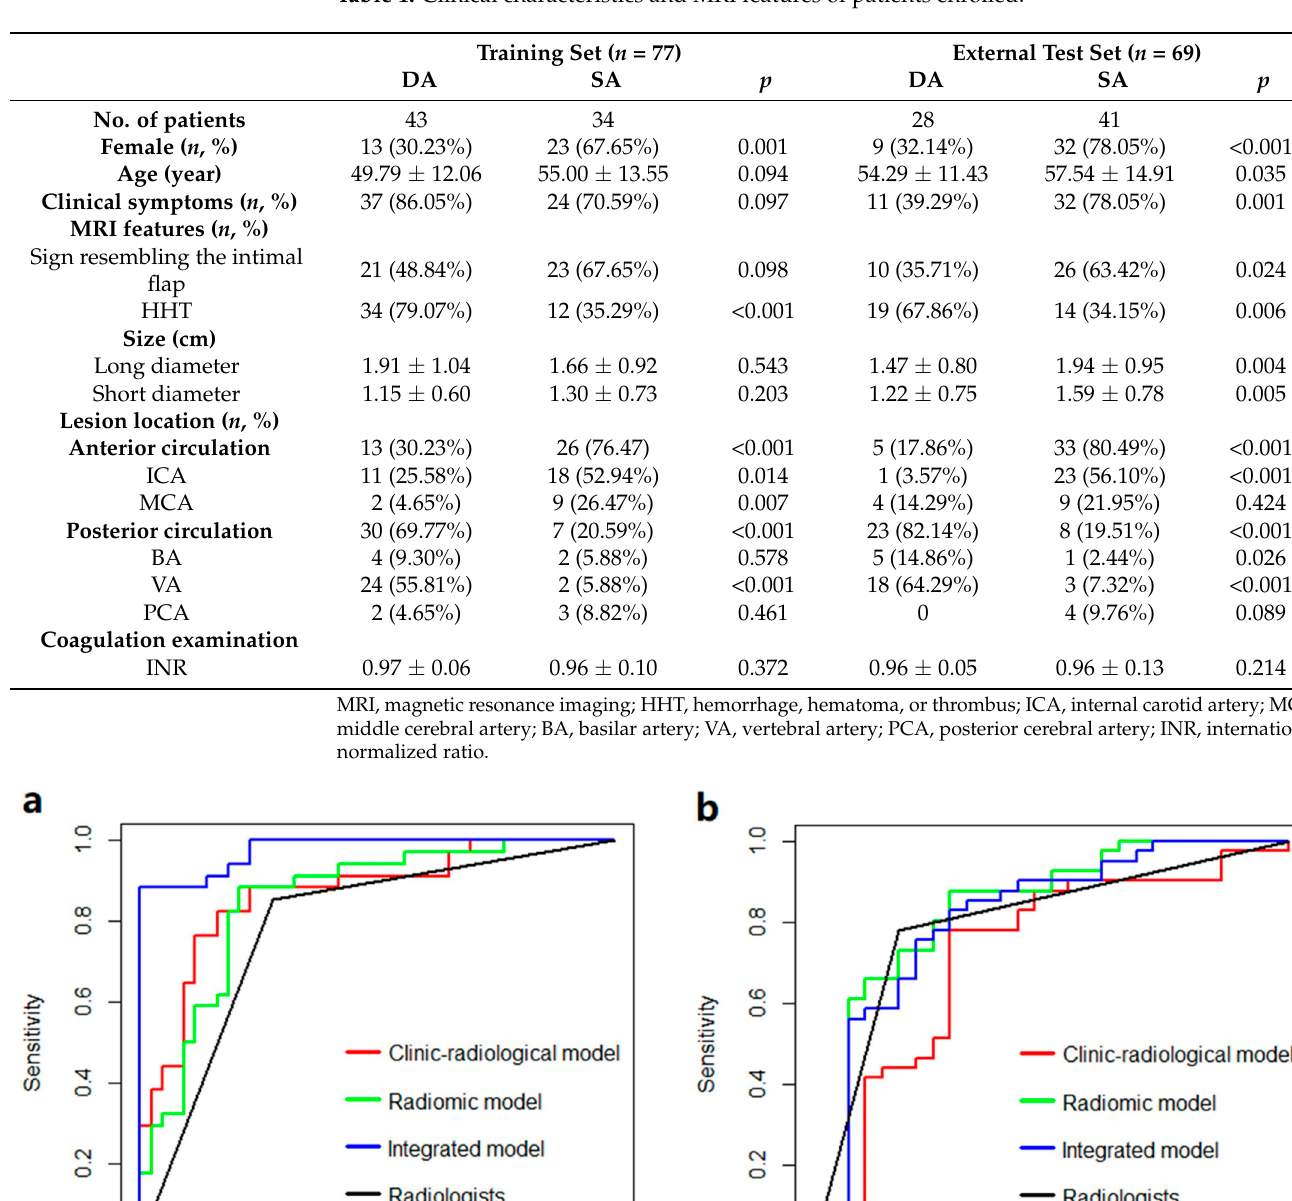
Table 1. Clinical characteristics and MRI features of patients enrolled.